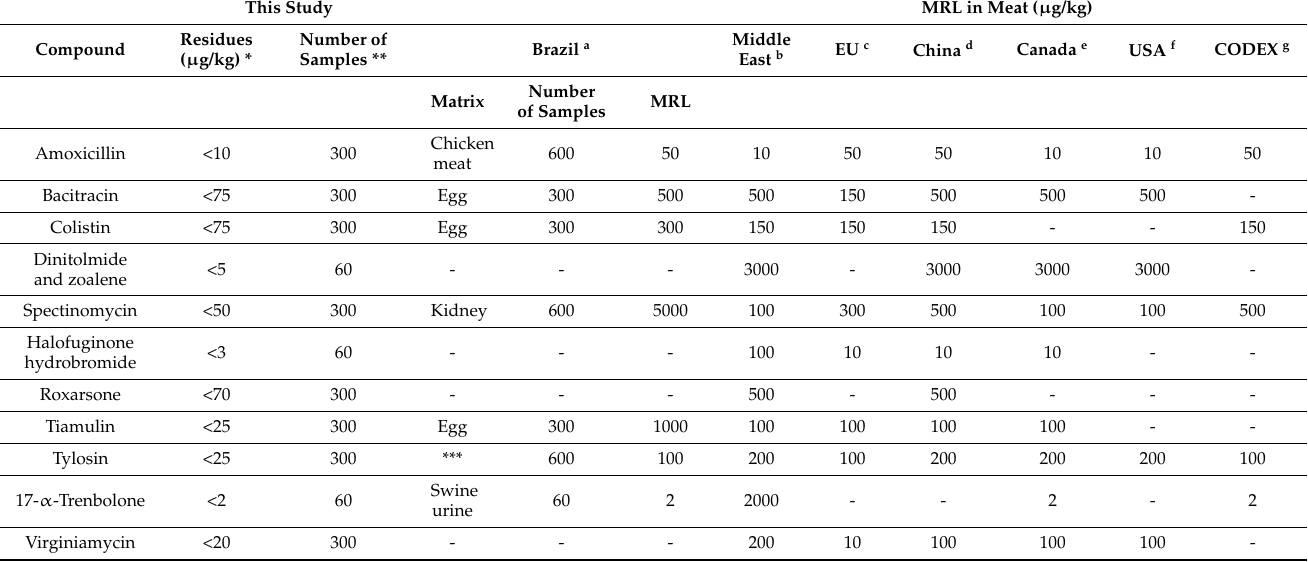
Table 1. Results of the eleven compounds analyzed in chicken meat and liver, number of samples evaluated for each matrix; Brazilian legislation (matrix, number of samples, MRL) compared to worldwide MRL legislation regarding these same residues in